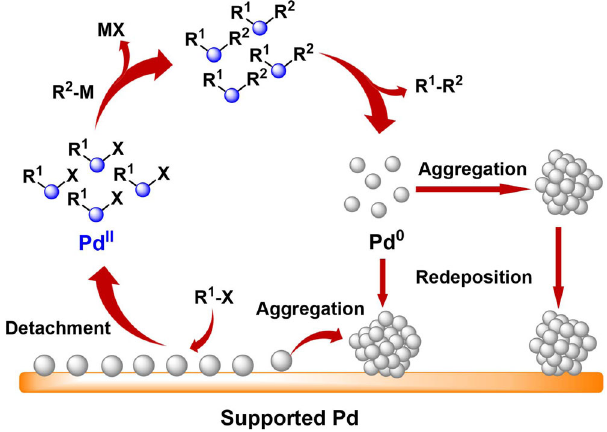
Fig. 1 Schematic illustration of catalyst evolution. The “ Cocktail ” type nature and evolution of the catalytic species in C – C bond formation reactions catalyzed by supported Pd